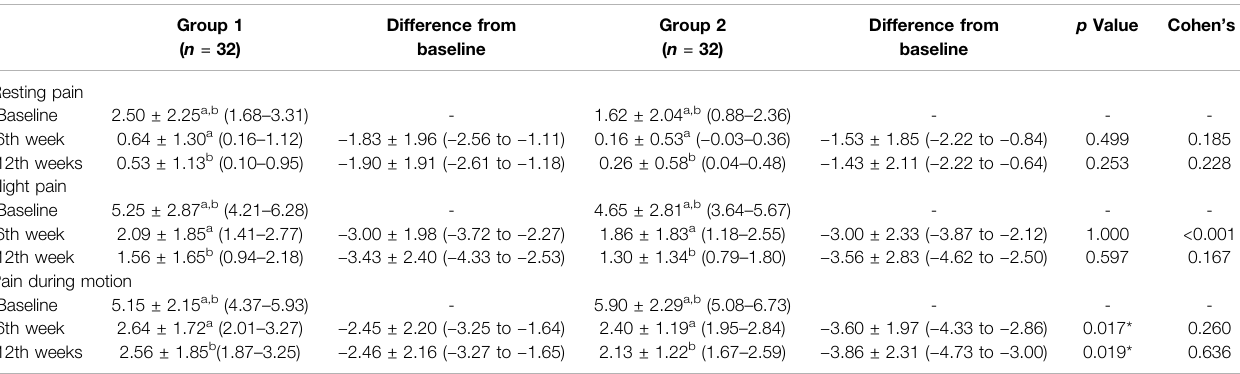
p Value Cohen ’ s d Difference from baseline